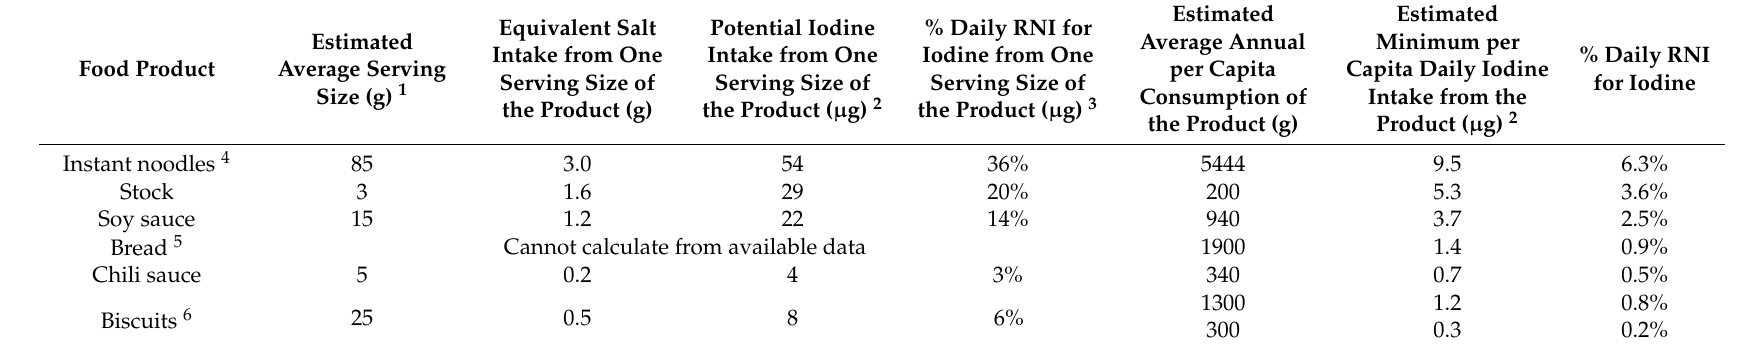
Table 3. Potential adult iodine intake from selected products in Indonesia if all salt used in production is iodised at the level of 18 mg/kg iodine.